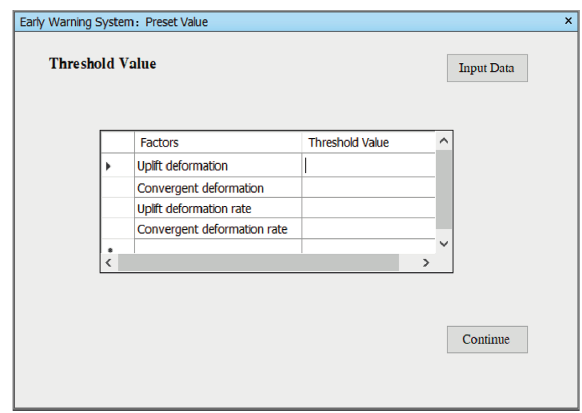
Figure 13: Interface for the preset threshold values.